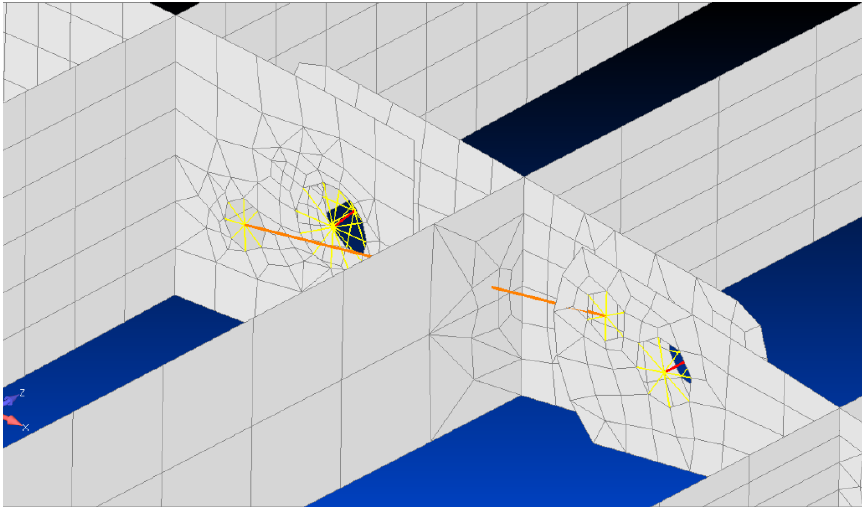
Figure 4. Hinges and pin modelling scheme of the reference finger-like morphing concept.